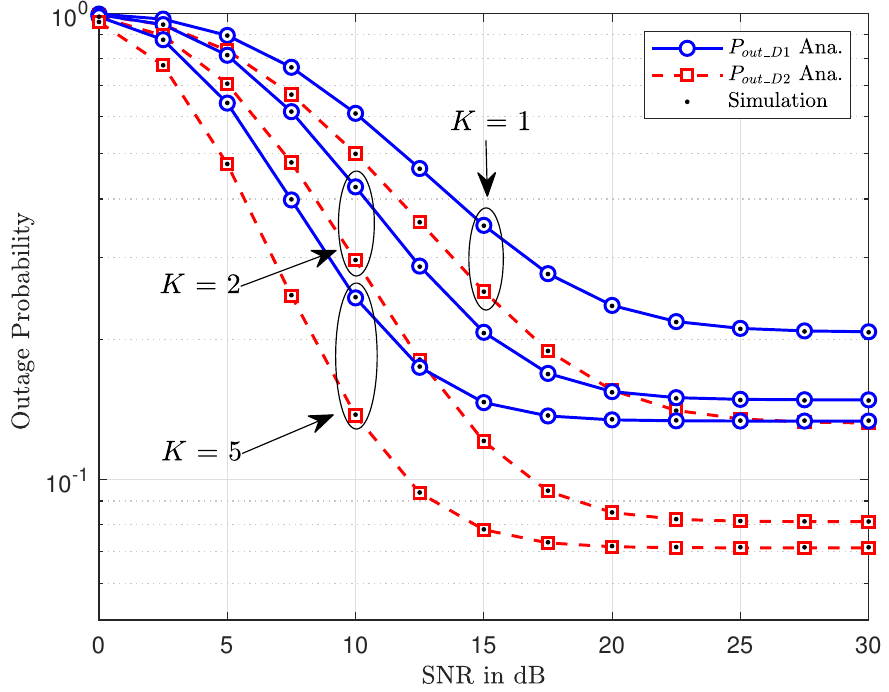
Figure 3. Outage performance of two vehicles versus SNR at the BS with different K